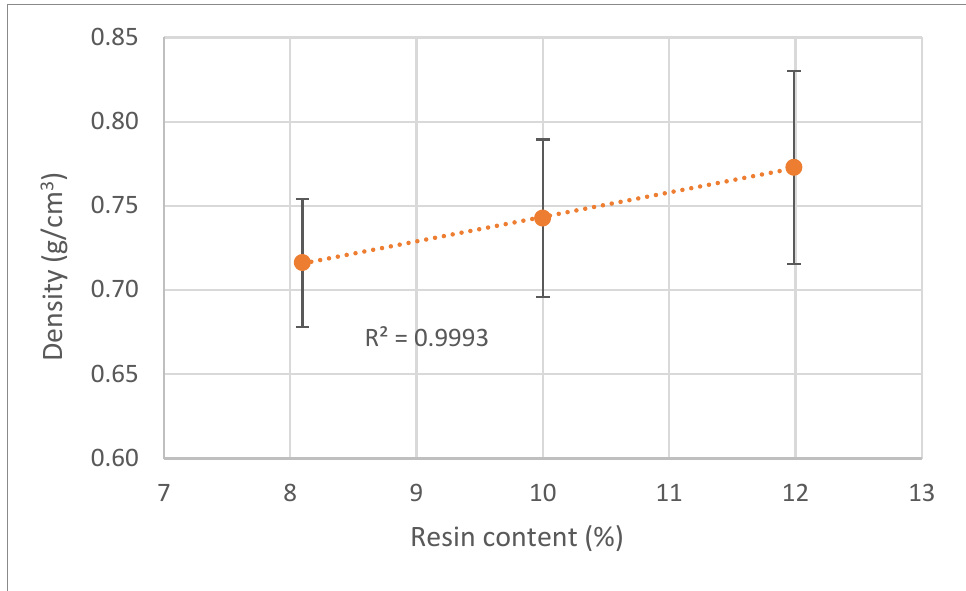
Figure 5. Correlation between board density variation and resin content.